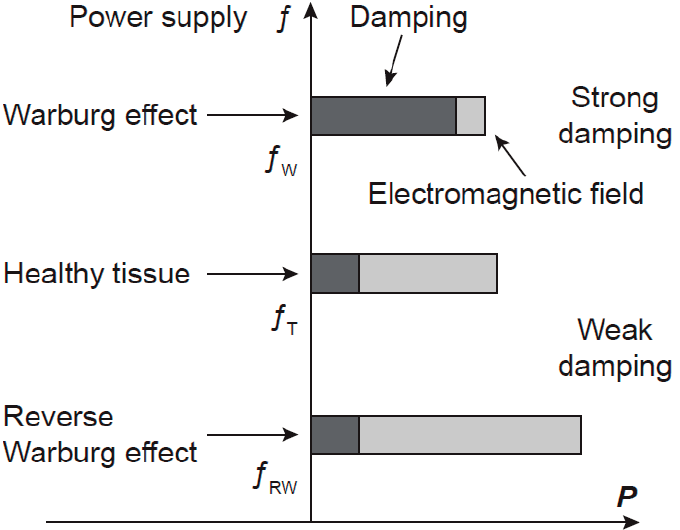
Figure 4. A hypothesis of the power-frequency relation of oscillations in cancer